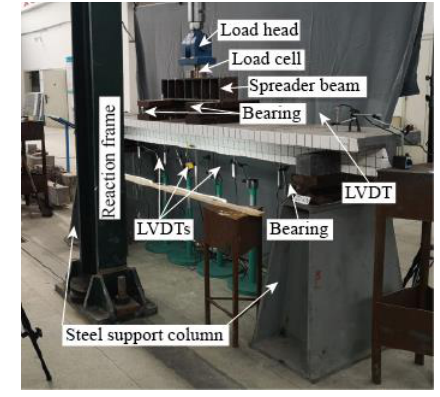
Figure 8. Experimental setup.